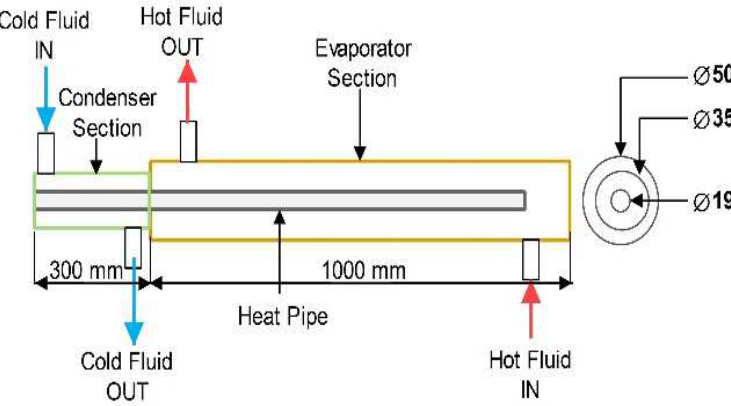
Figure 1. Schema of the concentric tube heat pipe heat exchanger. Table 1. Thermo-physical properties of working fluid.